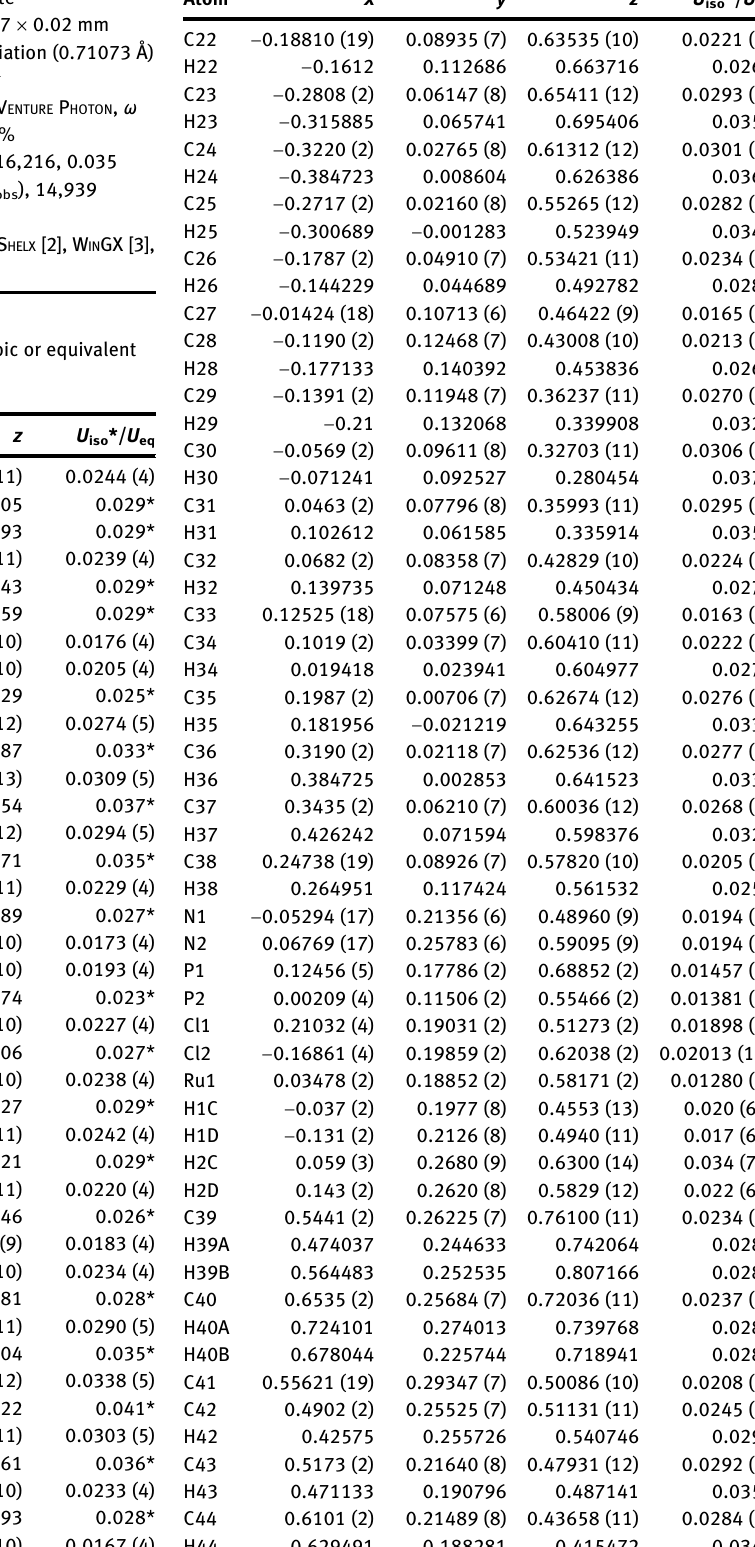
Table  : Data collection and handling. Crystal: